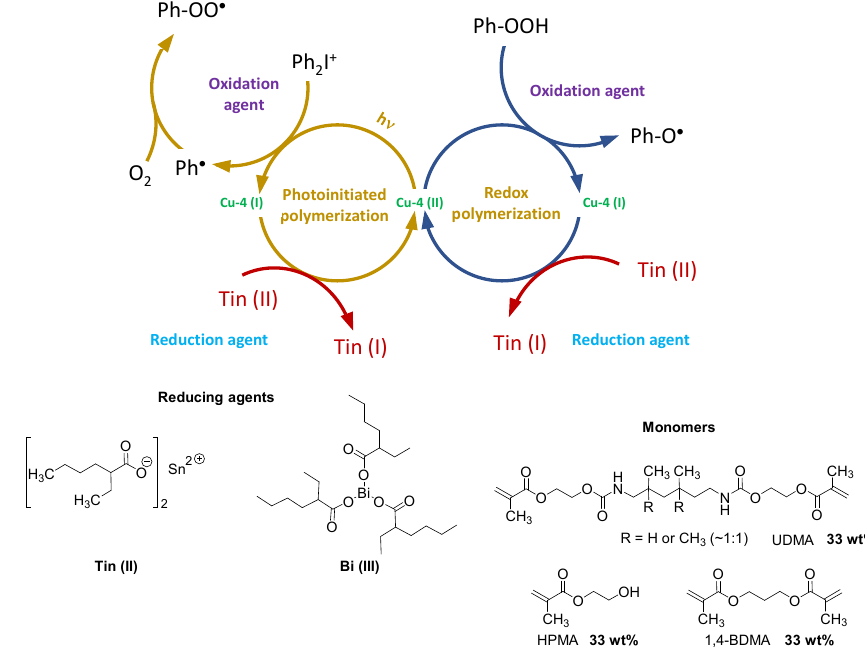
Figure 15. Concomitant photo and redox mechanisms involved in the polymerization in irradiated and shadowed areas. Chemical structures of the reducing agents and monomers used in this study.